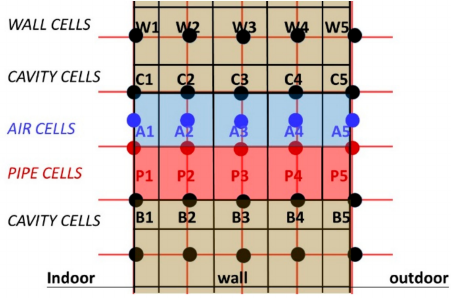
Figure 21. The nomenclature of the cells around the air cavity.